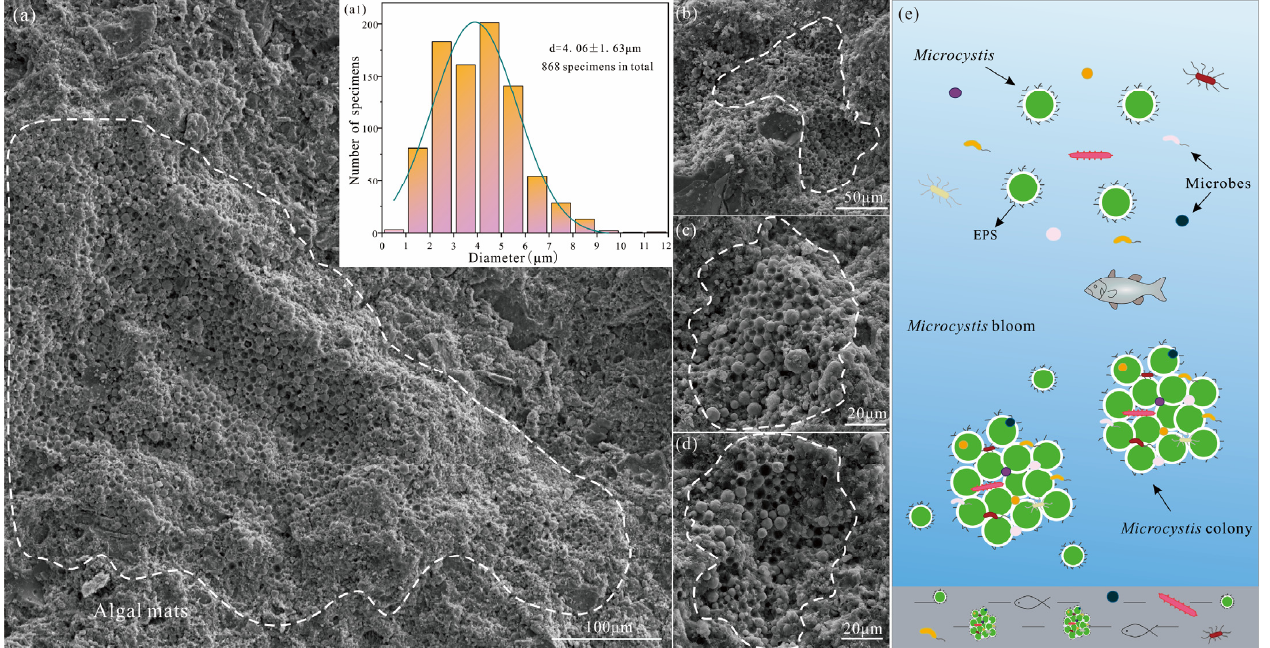
Figure 3. Microscopic photographs of Microcystis bloom in the upper Lucaogou Formation (J-17, 3574.2 m). ( a ) Sheet-like algal mats are widely distributed in the circled area. ( a1 ) Size distributions and the fitting curve of Microcystis spheroids (count: 868, mean: 4.06 μ m, standard deviation: 1.63 μ m) ( b – d ) Microcystis cells are irregularly integrated as colonies. ( e ) Schematic diagram of Microcystis colony formation and bloom.